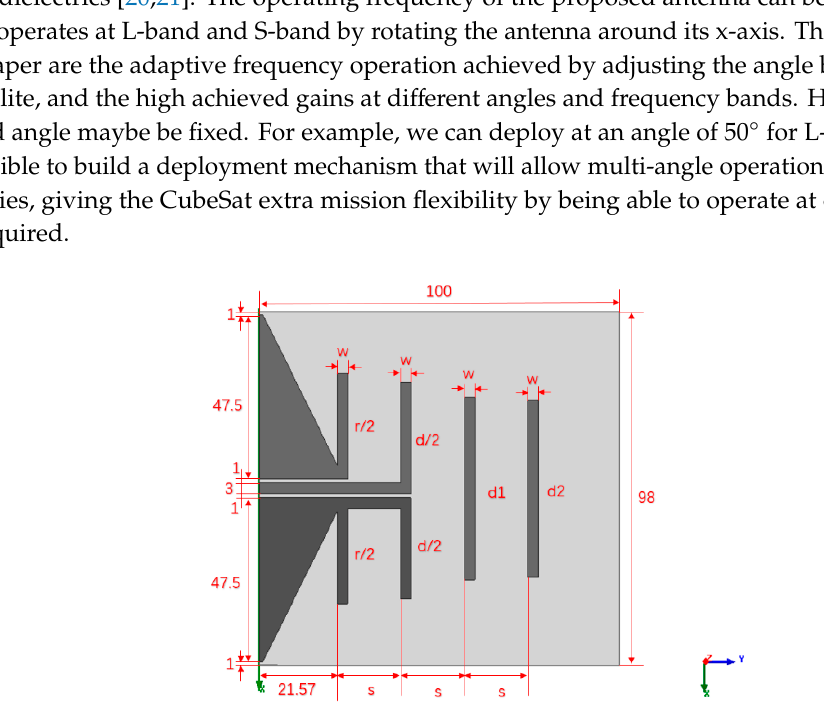
Figure 2. Layout of the printed Yagi antenna (units in mm).